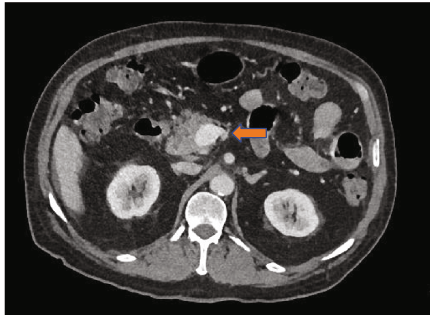
Figure 2: CT scan revealing perforation and collection at the distal ileum (arrow).